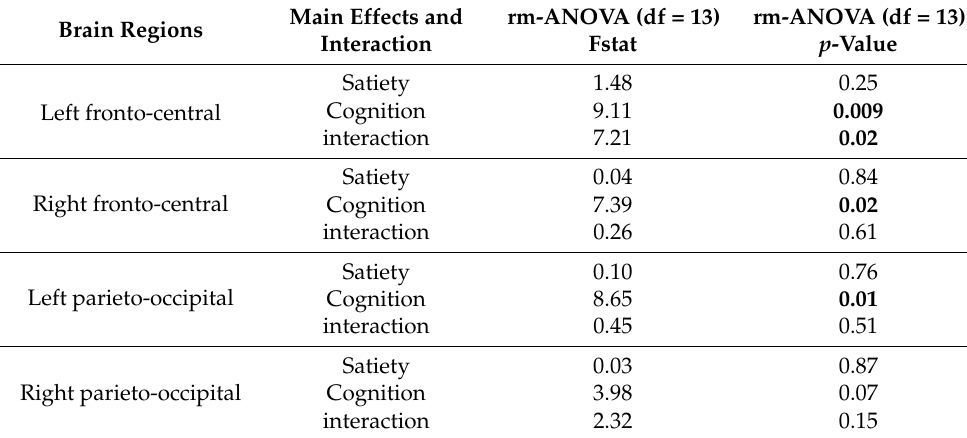
Table 2. Repeated measures ANOVA effects of satiety and cognitive state on PAC. The table summa- rizes the ANOVA Fstat and p -value, for the main effects and interactions for each of the brain regions. Significant p -values less than 0.05 are in bold. Main Effects and rm-ANOVA (df = Brain Regions Interaction